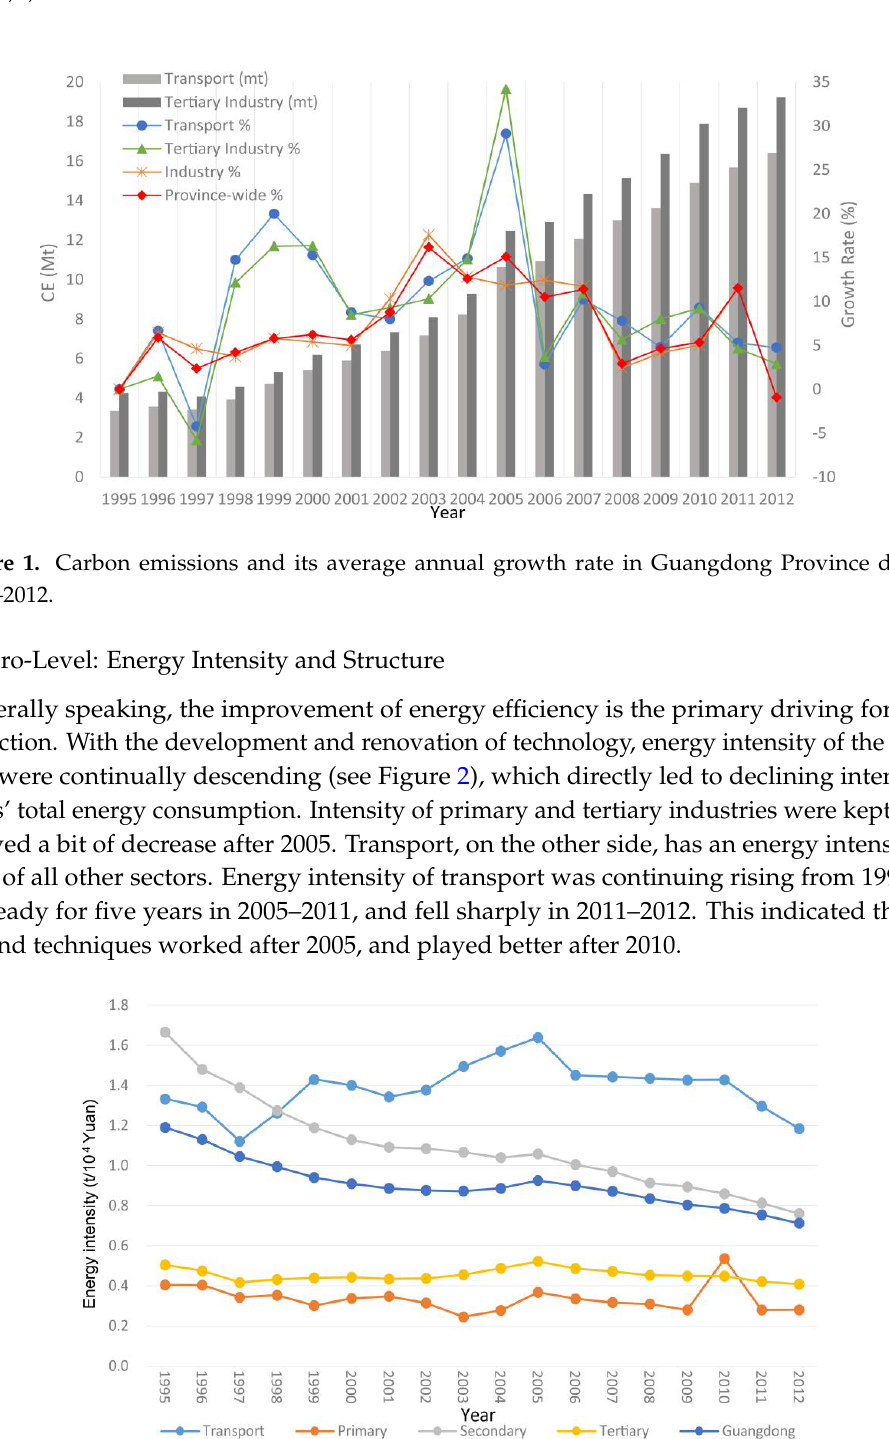
Figure 2. Energy intensity of transport sector, three main industries and the grand total in Guangdong.